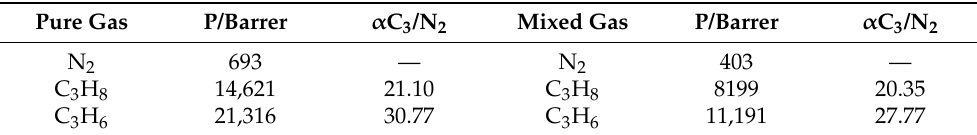
Table 5. Permeability coefficients and selectivity coefficients of C 3 /N 2 as pure gases and as mixed gases in PDMS at 298